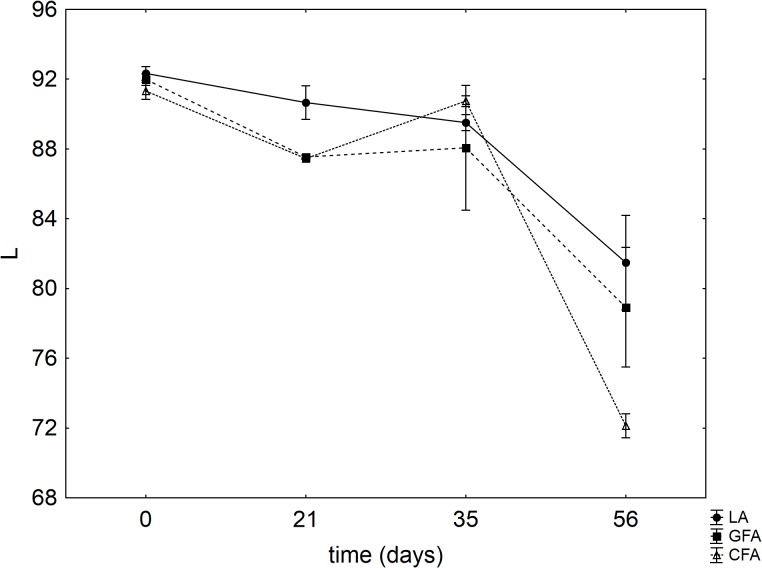
Evolution of L (mean values ± SE). LA, product with L. acidophilus; GFA, product with L. acidophilus and Gluten Friendly flour; and CFA, product with L. acidophilus and control flour. The numbers after the acronym of the samples indicate the days of storage (analysis after 7, 14, 21, 28, 35, and 56 days).